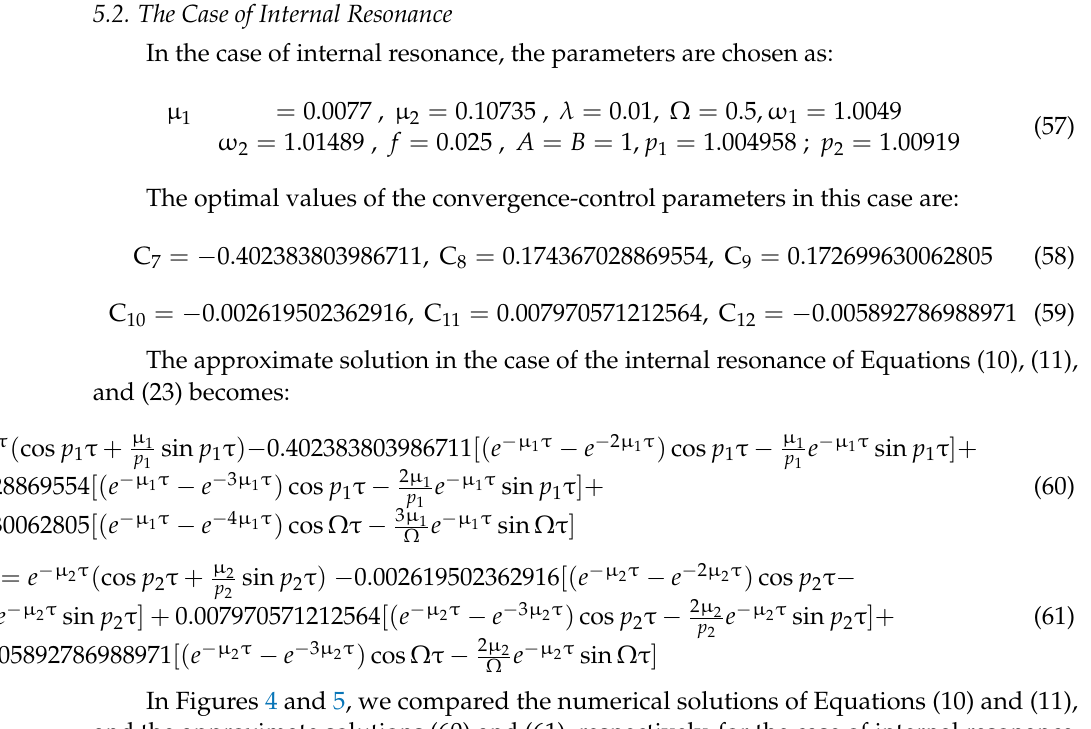
Figure 3. Comparison between the numerical solution of Equations (11) and (23) at simultaneous resonance and approximate solution (56) : ____ numerical integration solution; _ _ _ analytical solution.